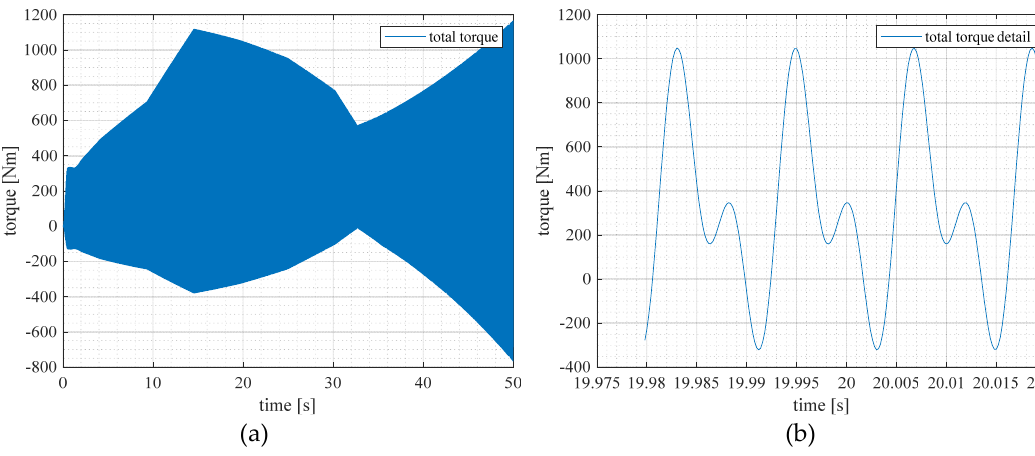
Figure 10. Total torque course measured on the shaft of ICE ( a ) and its detail during one testing cycle of the engine ( b ).